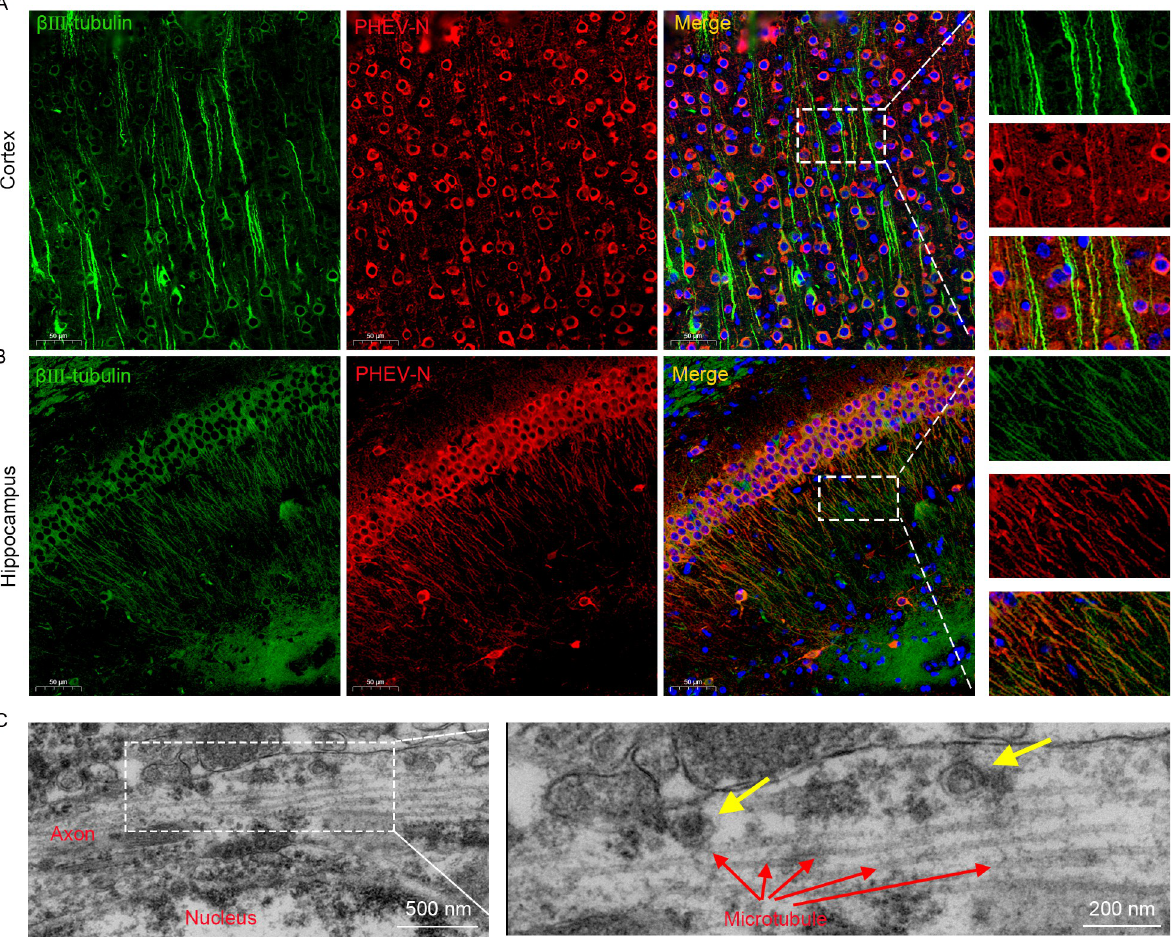
Fig 8. PHEV N protein and viral particles are associated with axons in vivo. The 3w BALB/c mice were intranasally inoculated with 10 3.96 TCID 50 PHEV. (A-B) Brains were collected at 5 dpi, sagittally sectioned, and subjected to immunofluorescence staining with β III-tubulin (green) and PHEV-N protein (red) antibodies. The nuclei were stained with DAPI (blue). (C) Brains were collected at 5 dpi and analyzed by TEM. Red arrows, microtubules. Yellow arrows, virus